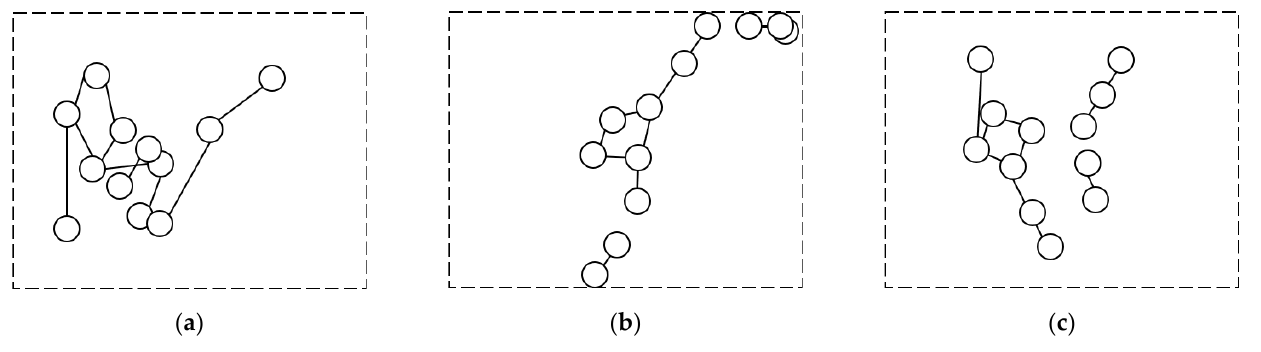
Figure 1. Example of random layout , spring layout and organic layout: ( a ) Random layout; ( b ) Spring layout; ( c ) Organic layout.